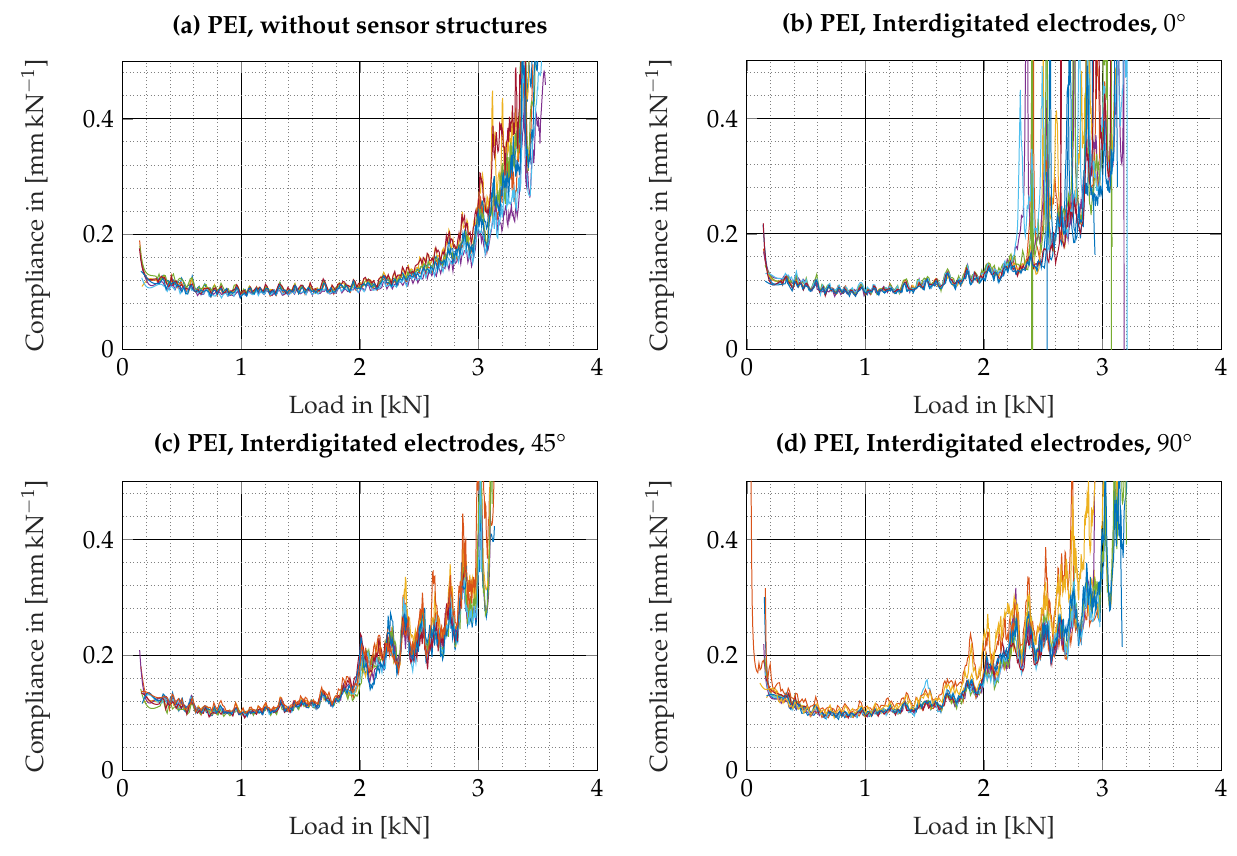
Figure 7. Compliance over bending force curves for several ILS specimens with spin-coated PEI film: ( a ) PEI film, without sensor structures. ( b ) PEI film, with thin tracks @ 0°. ( c ) PEI film, with thin tracks @ 45°. ( d ) PEI film, with thin tracks @